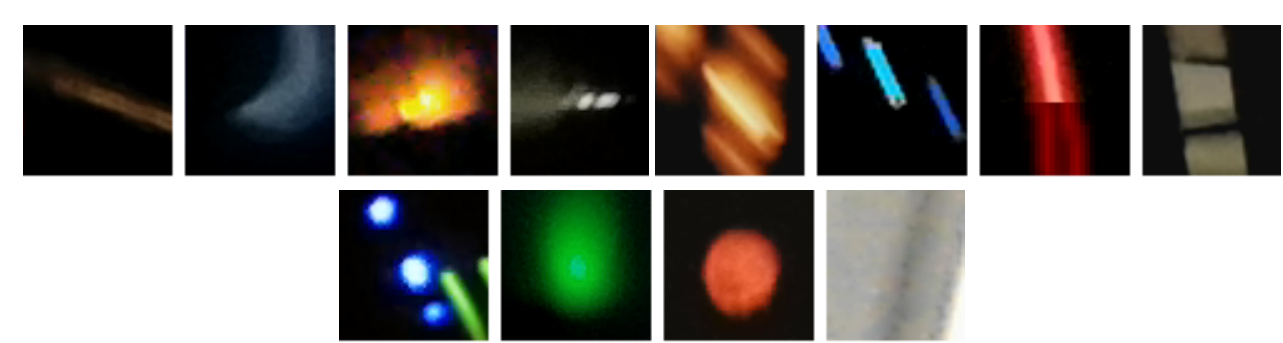
Figure 3. Example of bad detections in an application classified as artefacts. Artefacts are usually the result of not covering the camera, being too close to a light source or user interference in creating